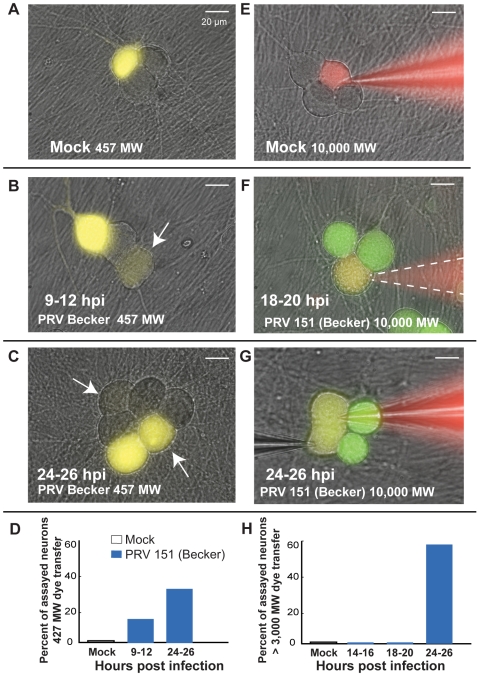
Increasingly larger molecular weight dyes transfer between neurons as infection proceeds.(A) Lucifer yellow (LY, 457 MW) dye did not transfer from filled mock-infected cell bodies to other cell bodies (0/10). Images represent overlays of excited Lucifer yellow onto bright field images. (B–C) Transfer of LY to other cell bodies could be seen in PRV 151 infected neurons by 9 hpi,(2/12). White arrows indicate cell bodies that contain dye transferred from the filled neuron. Transfer of LY from filled cell bodies to other cell bodies was more common in PRV 151 infected neurons by 24 hpi (2/6). Note that PRV 151 infected cell bodies that contained transferred dye were generally not adjacent to filled cell body, and were exclusively to non-adjacent cell bodies early (9–12 hpi). (D) Percentage of neurons assayed in which dye spread from the filled cell body to another cell body. (E) Texas-red dextran conjugates (3,000–40,000 MW) to not transfer from filled cell bodies of mock-infected neurons to other cell bodies (0/9). (F–H) Large dye transfer between infected neurons occurs late in infection (14–16 hpi, 0/9, 18–20 hpi, 0/9, 24–26 hpi, 11/19). Neurons selected for dye filling were chosen as potentially fused cells based on outer membrane contours by light microscopy. Green – GFP expressed from viral genome, Red – Texas-red dextran conjugate, Yellow – overlap of green and red images. Panel F, bright field image was recorded following fluorescence image and pipette removal; pipette location is indicated by a dashed while line.